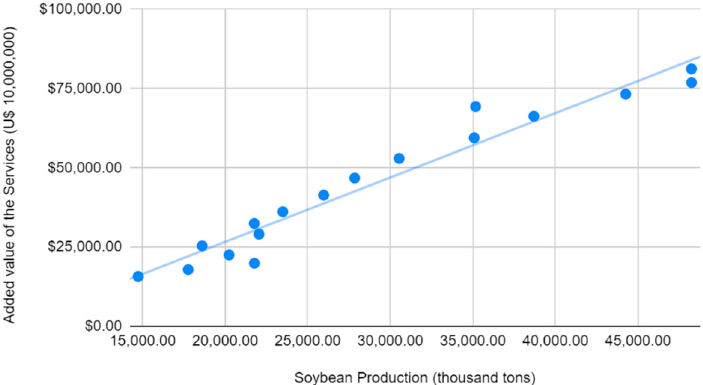
Figure 13. Correlation chart: added value of the services to GDP and soybean production. Prepared by the authors.